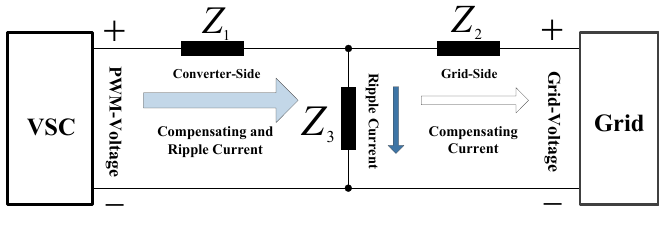
Figure 8. Diagram of the current flow path in the LCL